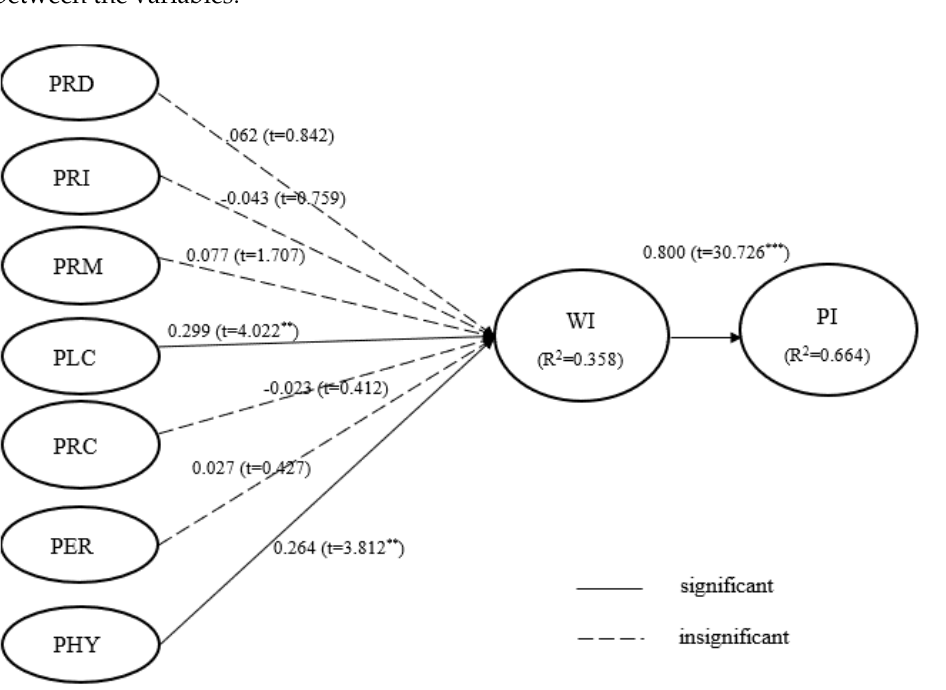
Figure 4. Research framework for test the mediating effect of watching intention (Model 3). The following hypotheses were proposed: Hypothesis 8 (H8). The service marketing mix is positively associated with customers’ purchase intention.